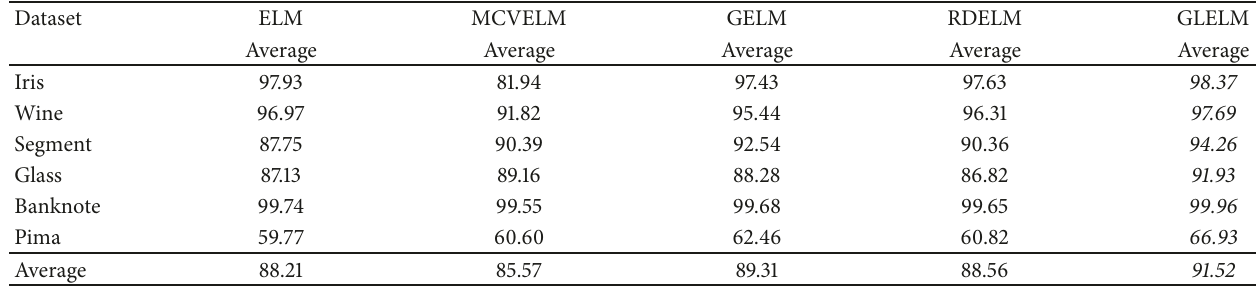
Table 3: Average (sum average recognition rate of different training samples per subject) recognition rate of different ELM algorithms on the UCI datasets